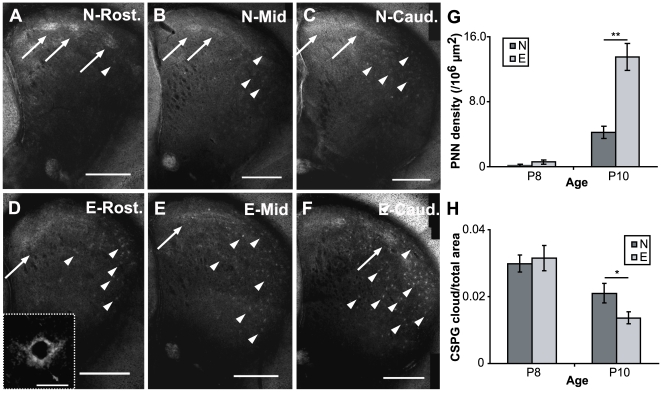
Enrichment accelerates the striatal maturation as determined by the pattern of CSPG staining at P10.(A–C) A rostral (rost.) to caudal (caud.) series showing the pattern of CSPG staining in the striatum at P10 in non-enriched mice. CSPG staining in the striatum is most prominent in diffuse clouds (some highlighted by arrows) which we have previously shown to be associated with striosomes [36]. PNNs, characterised by more punctuate staining, can also be seen in the matrix (arrowheads) but these are present at very low density. Only one or two can be seen in sections from rostral striatum (A), though they become slightly more numerous in mid (B) and caudal (C) sections. (D–F) A similar series to that shown in A–C but for enriched mice. Here, the CSPG-associated clouds (arrows) are much less apparent. PNNs are, however, markedly more numerous and more prominent across all rostrocaudal levels compared to non-enriched mice. The inset in 4D shows the appearance of the PNNs at higher power. Note the characteristic lattice-like network of CSPGs encircling the soma and proximal dendrites. Scalebars: 500 µm in A–F, 20 µm for the Inset in D. (G–H) Graphs plotting increases in PNN (G) and decreases in CSPG cloud (H) densities in enriched mice at P10. Differences are significant (see text for details). Nine sections from 3 animals were quantified for each group. *: p<0.05, **: p<0.001.